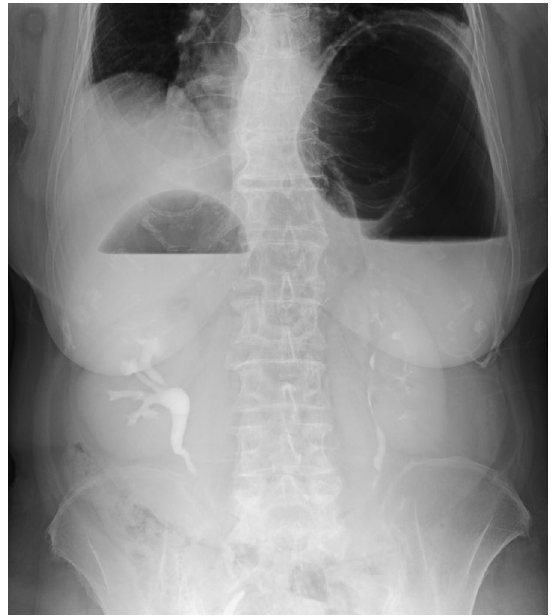
Fig. 1 Erect chest and abdomen X-ray showed a double air-fluid